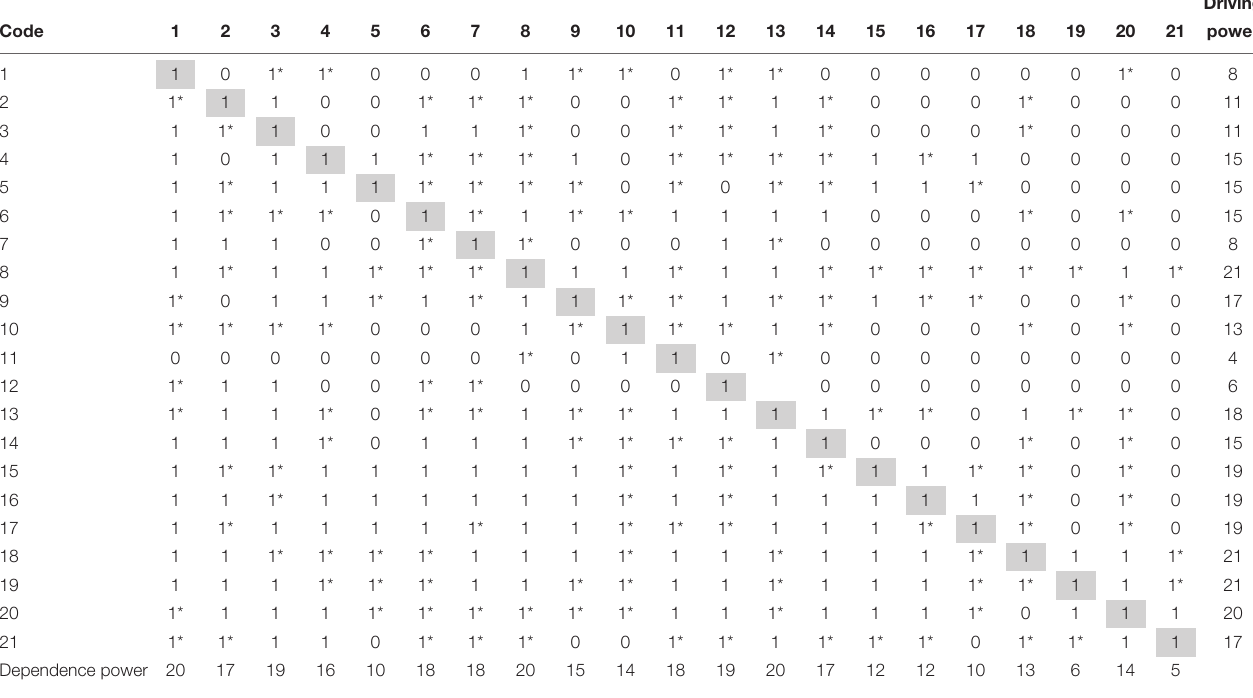
TABLE 4 | Final reachability